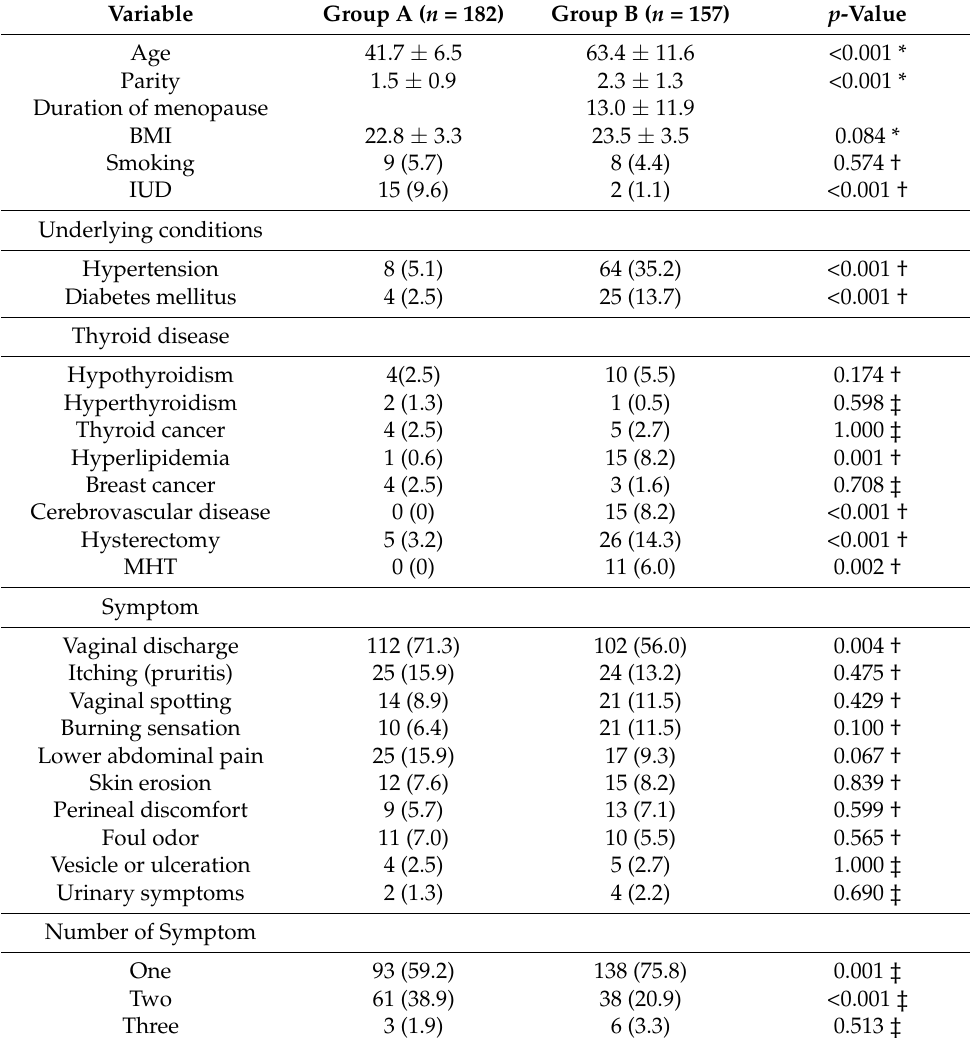
Table 1. General characteristics of